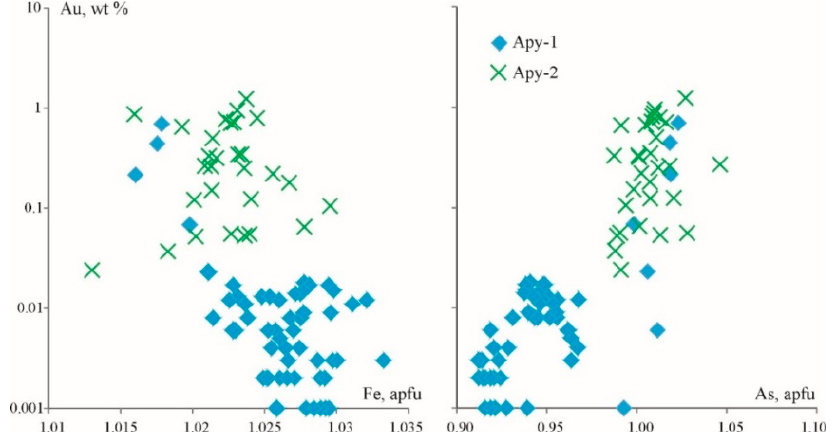
Figure 42. Relationship of Au content with the main elements (Fe and As) in the studied arsenopyrite samples of the Vorontsovka Carlin-style deposit. Blue diamonds—arsenopyrite from skarn complex (Apy-1); green crosses indicate highly arsenic arsenopyrite of the gold-pyrite-realgar assemblage